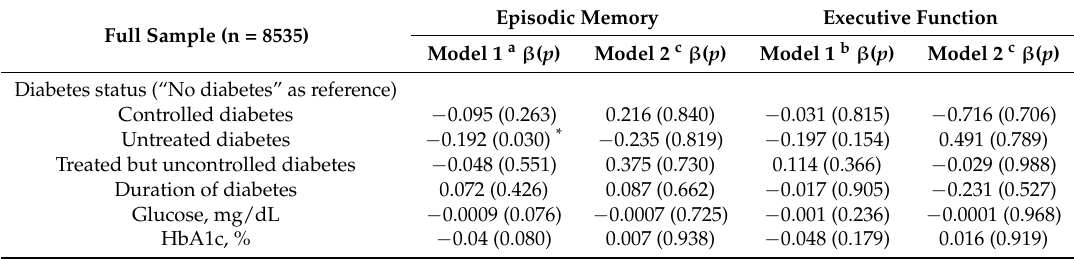
Table 3. Association between diabetes status and cognition in full sample (n =